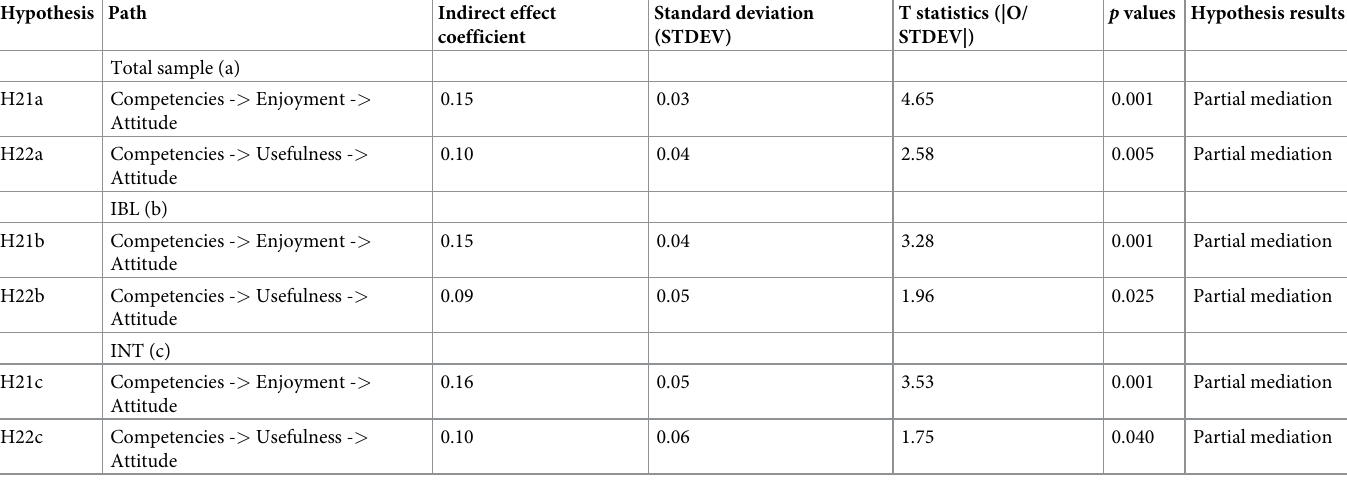
Table 9. Specific indirect effects for the total sample (a), IBL (b) and INT (c) teaching practices. Hypothesis